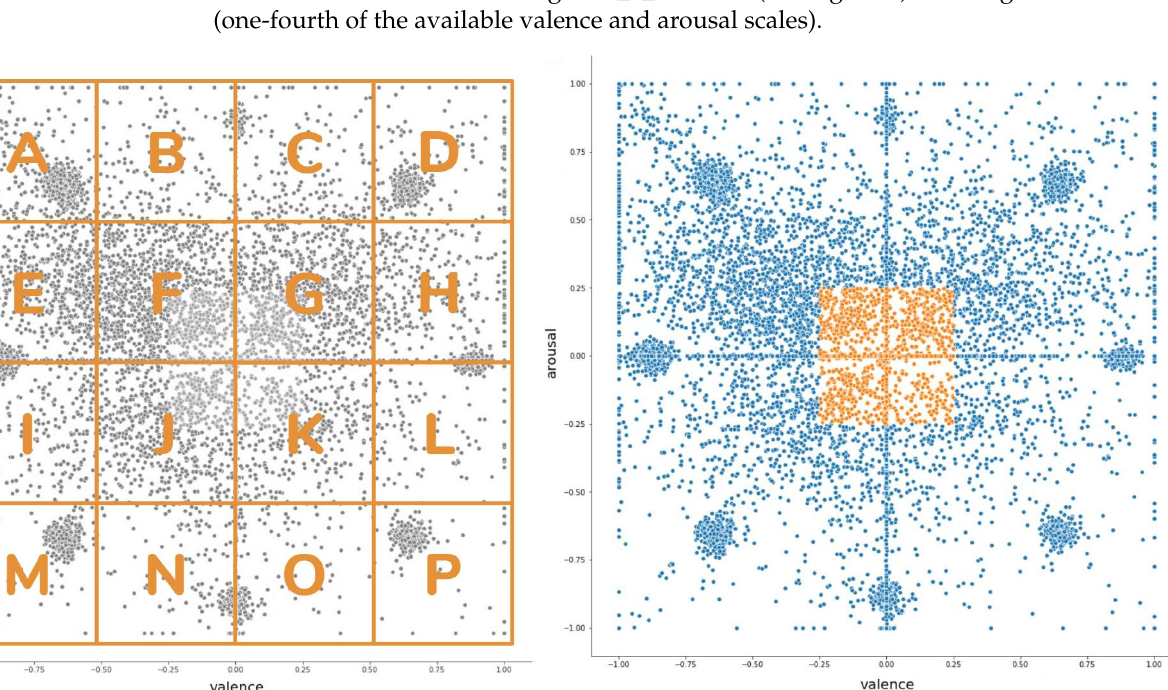
Figure 6. The split of ratings in the emospace widget into clusters ( left ). Cluster _0_ introduced as an intercept for emospace-related analyses ( right